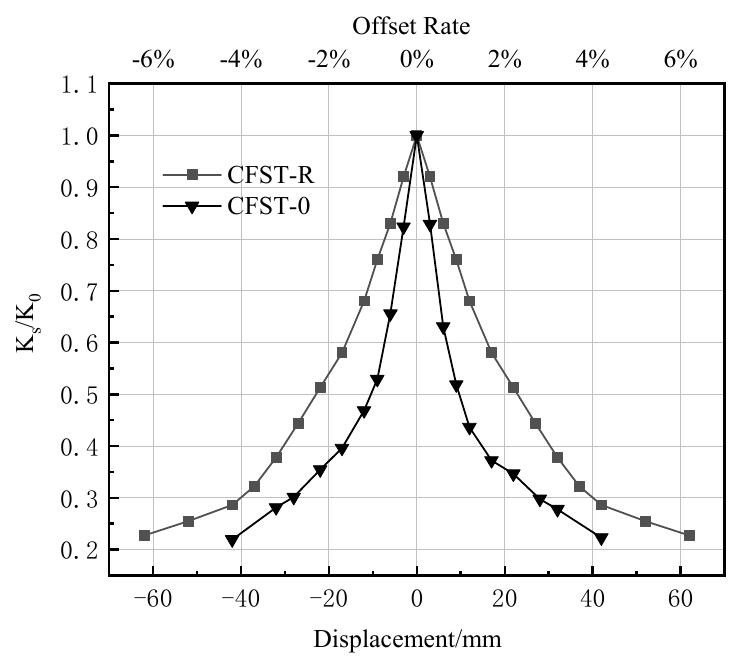
Figure 16. Stiffness degradation law.